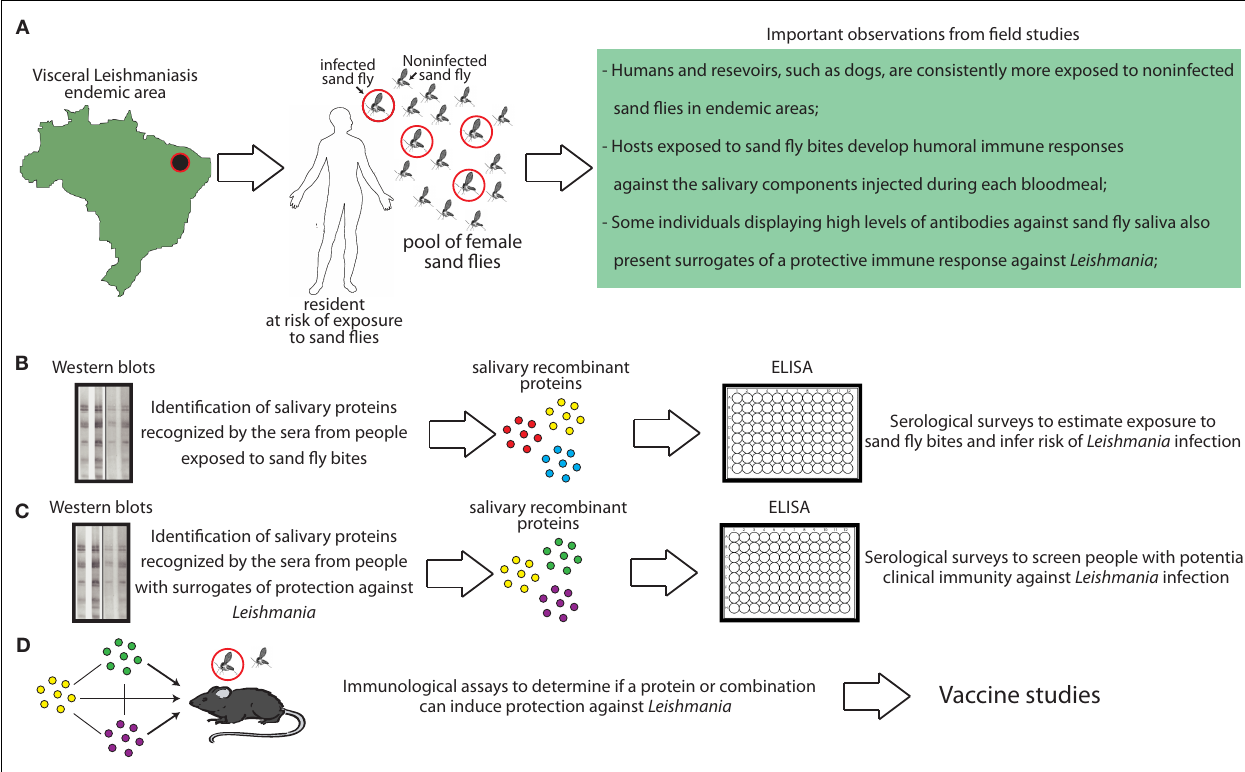
the host humoral responses. Such proteins can be used in serological surveys to estimate exposure to sand fly bites and an overall risk to become infected in endemic areas. (C) Other salivary proteins are more frequently recognized by antibodies from people presenting surrogates of clinical immunity